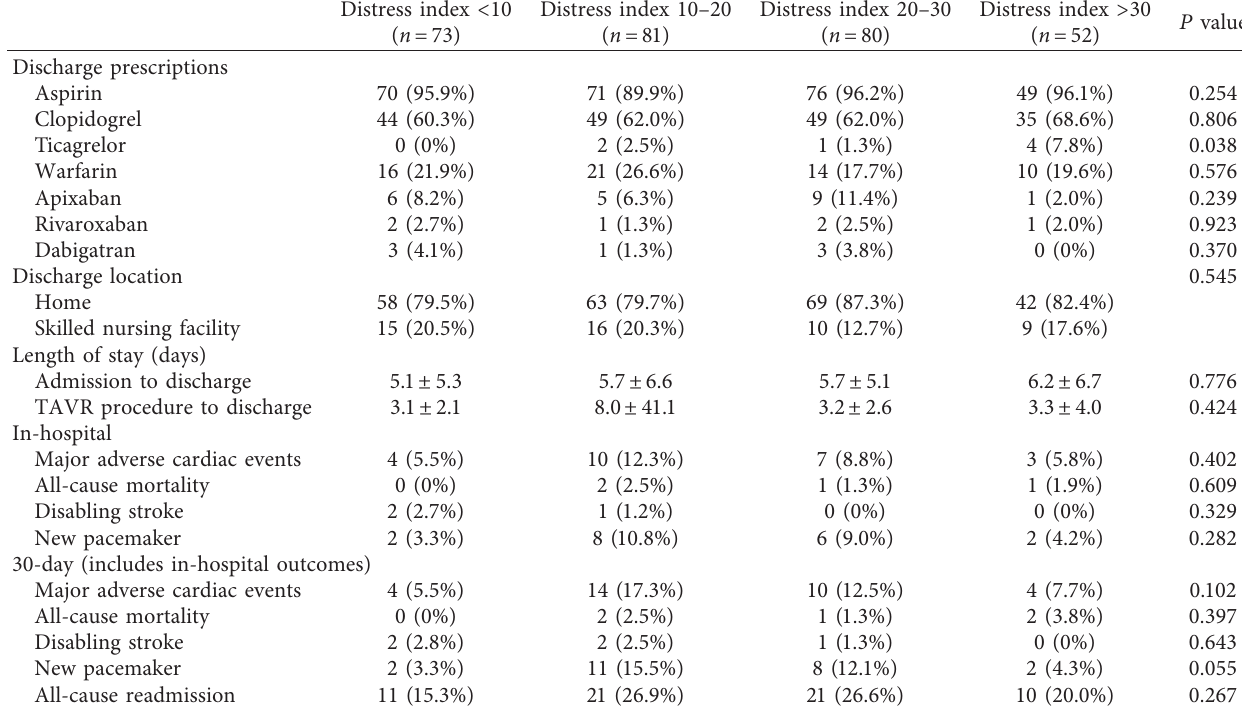
Table 4: Discharge